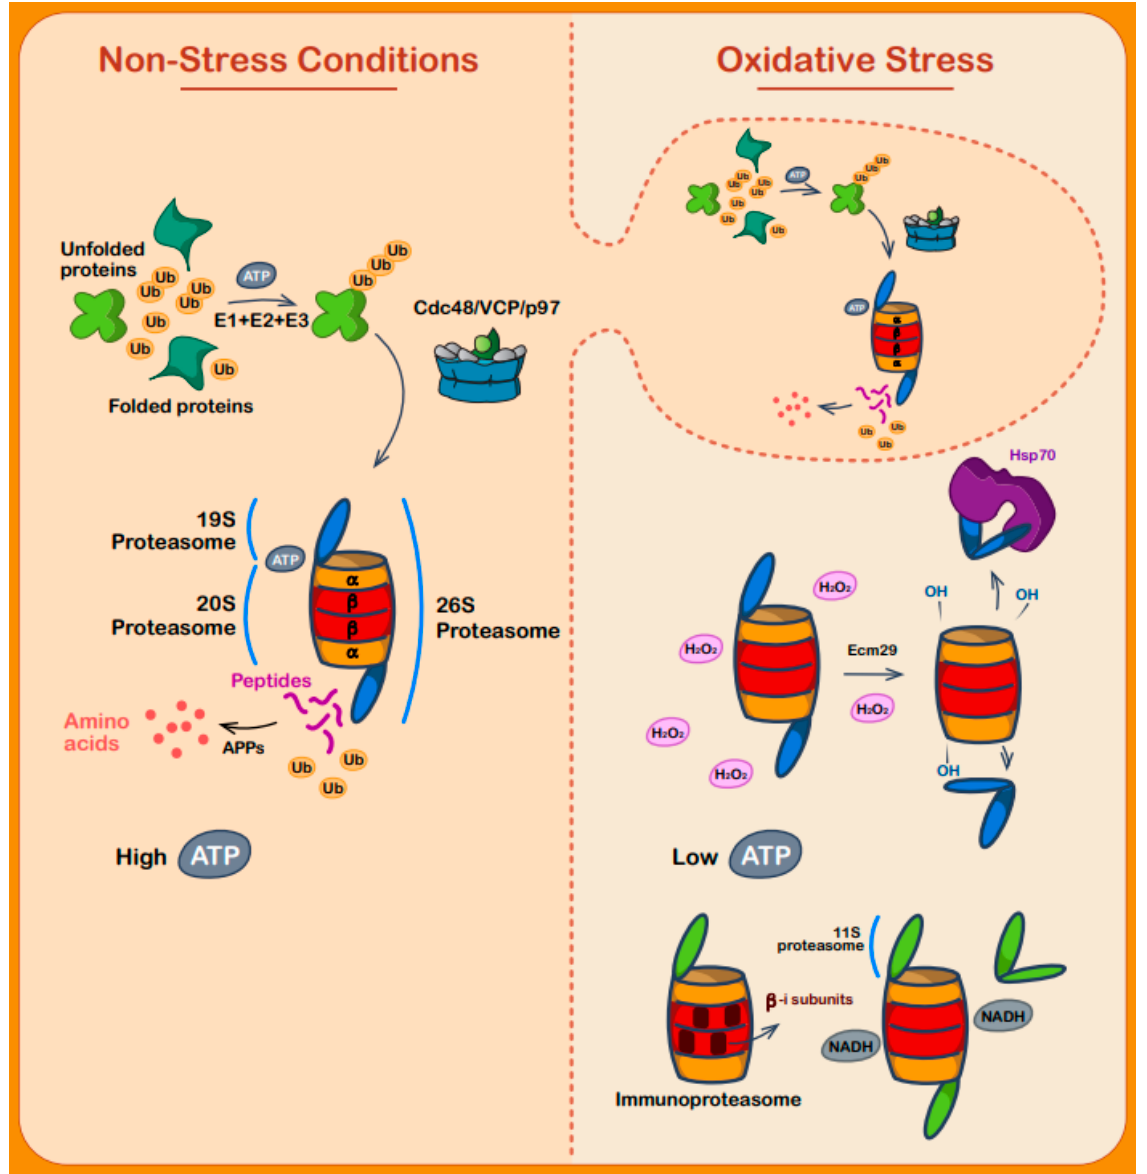
Figure 4. Proteasome-mediated protein degradation during oxidative stress. To the left, under non-stress conditions and in a high ATP environment, unfolded and misfolded proteins undergo degradation by the ubiquitin system by tagging the targeted proteins with ubiquitin (as carried out by the E1, E2, and E3 enzymes), then reaching the 26S proteasome with the aid of different shuttle proteins. The client proteins are initially recognized by the 19S particle. Following binding and utilization of the energy stored in ATP molecules, the substrate unfolds to its primary structure and enters the hollow barrel-like structure of the 20S particle. The substrate is then degraded into peptides by the catalytic units of the beta- subunits, while aminopeptidases (APPs) break them down to amino acids after the peptides exit the proteasome. To the right, oxidative stress conditions alter the cell mechanism of dealing with misfolded and unfolded proteins. The previously described ubiquitin-based degradation system is minimized by the decrease in ATP molecules, and the 26S proteasome comes apart. The 19S and 20S particles split, mediated by the Ecm29 protein and Hsp70. While the 19S is held by Hsp70, the now-oxidized 20S particle begins to function by itself in an ATP-independent manner and degrades unfolded and misfolded proteins. Under these conditions, another kind of proteasome—the 20Si (immunoproteasome)—is upregulated. This proteasome is combined with 3 different beta-subunits (see text), enhancing the proteasome’s catalytic abilities. The 11S or PA28 subunits are upregulated, serving as an alternative regulatory unit for the 20S and 20Si proteasomes, while NADH stabilizes the proteasome structure in the absence of